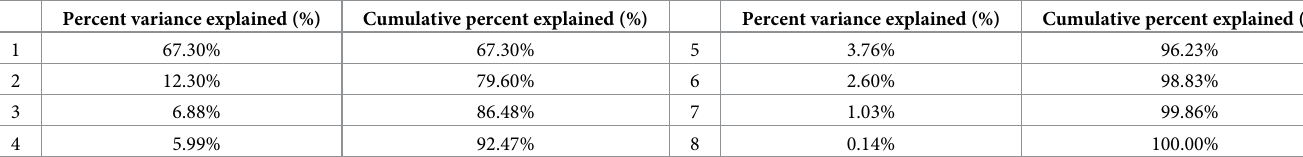
Table 3. Results of the first step